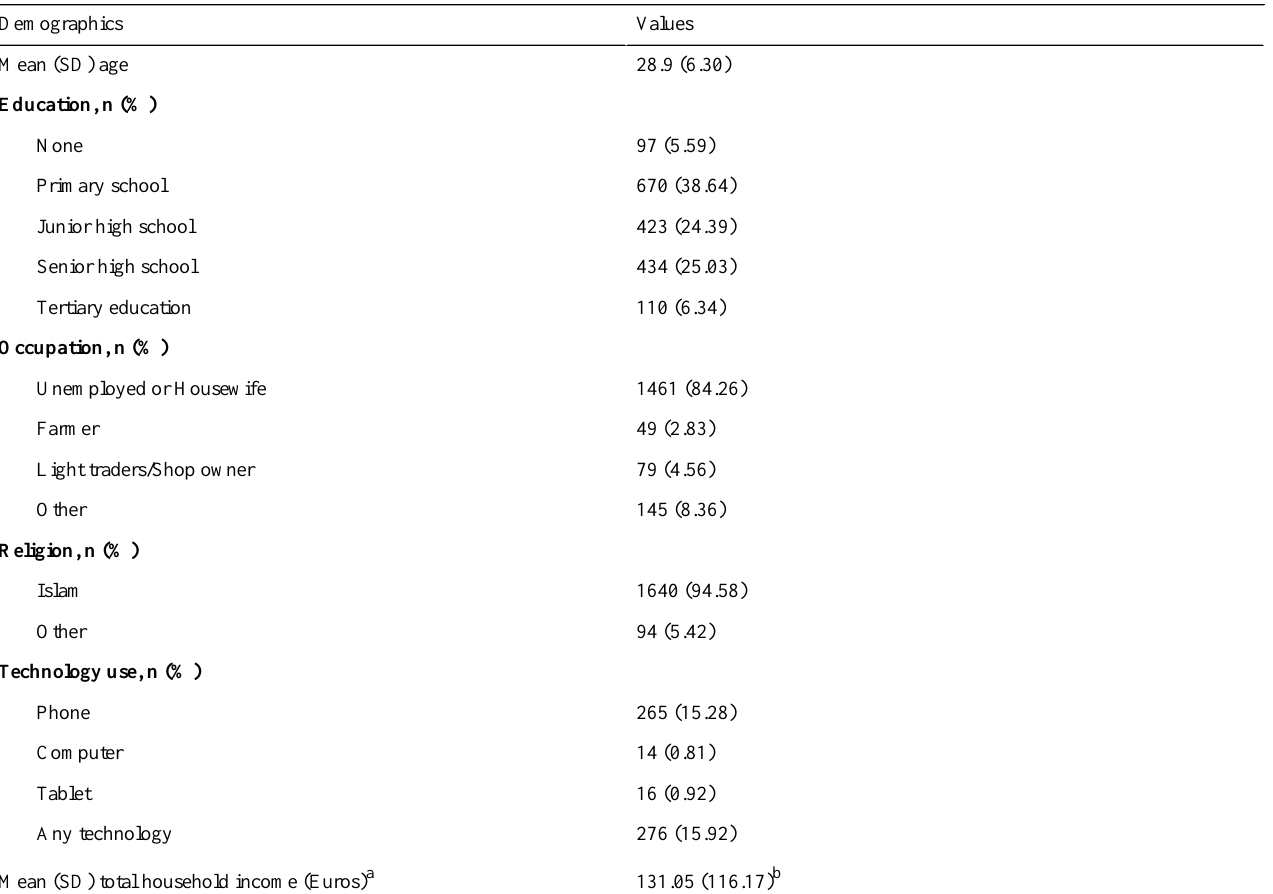
Table 1. Participant demographics in Banyuasin, Kubu Raya, and Katingan in 2018